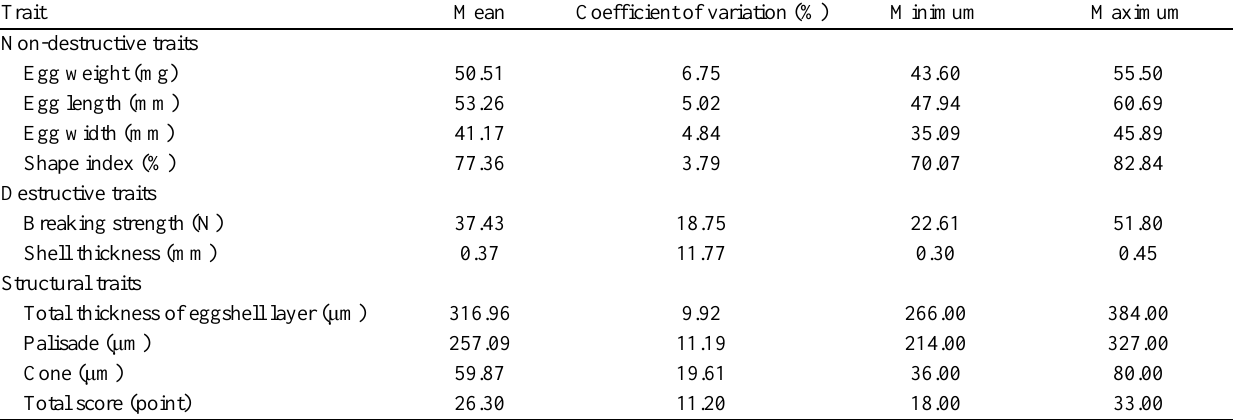
Destructive traits Breaking strength (N) Shell thickness (mm) Structural traits Total thickness of eggshell layer